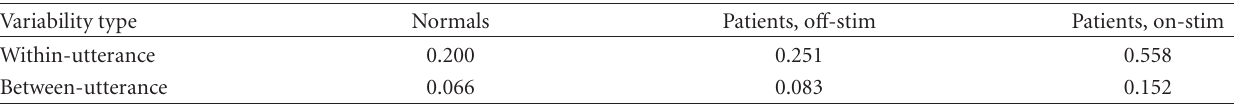
Table 3: Bilabial within- and between-utterance syllable rate variability by group. The first row shows within-utterance relative deviation or syllable rate. The second row shows between-utterance, within-session mean syllable rate relative deviation. All results are averaged across all sessions of the indicated participant group.